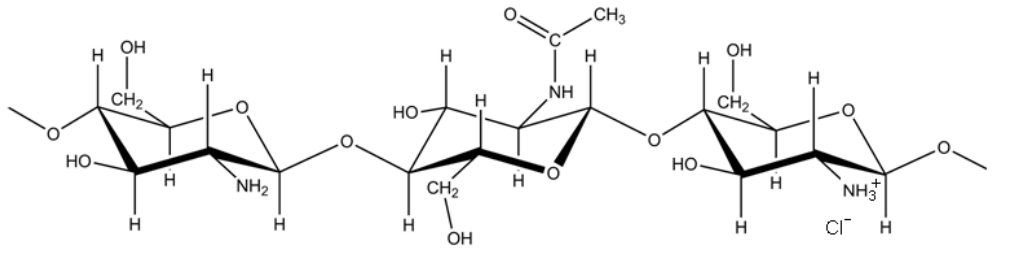
Enzymatic degradation of chitosan by serum lysozyme requires three consecutive GlcNA